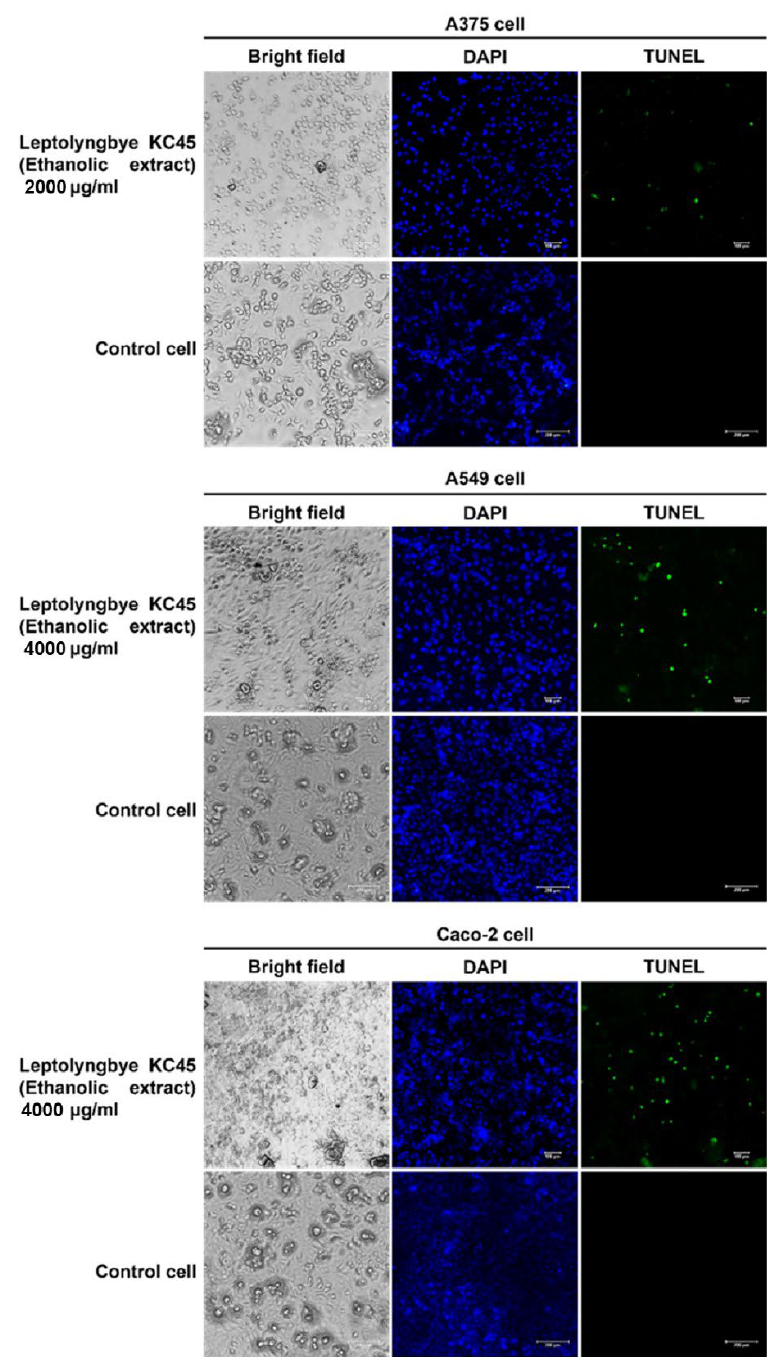
Figure 7. Terminal deoxynucleotidyl transferase dUTP nick end labeling (TUNEL) assay of skin cancer A375 cells, lung cancer A549 cells, and colon cancer Caco-2 cells after treatment with the ethanolic extract from cyanobacteria, Leptolyngbya sp. KC45, when compared with control cells, i.e., normal Vero cells, for 48 h. The cells were stained with 4′,6 -diamidino-2-phenylindole (DAPI) and TUNEL, and observed under a fluorescent microscope.